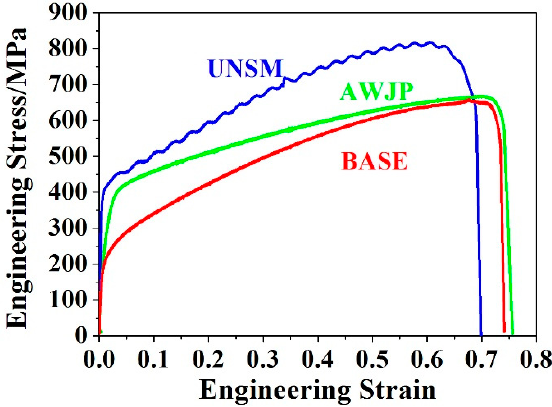
Figure 9. The engineering stress-strain curves of the 304 stainless-steel BASE, AWJP, and UNSM specimens.